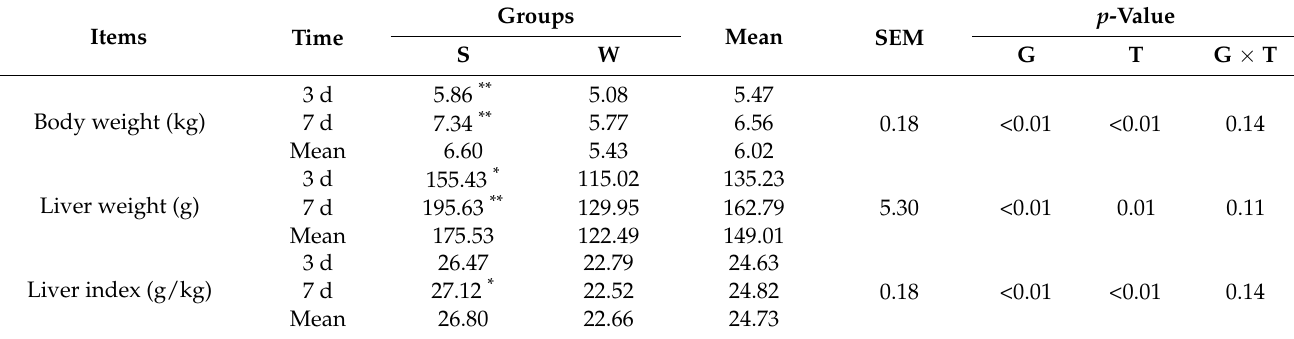
Table 3. Effects of weaning on the development of liver in